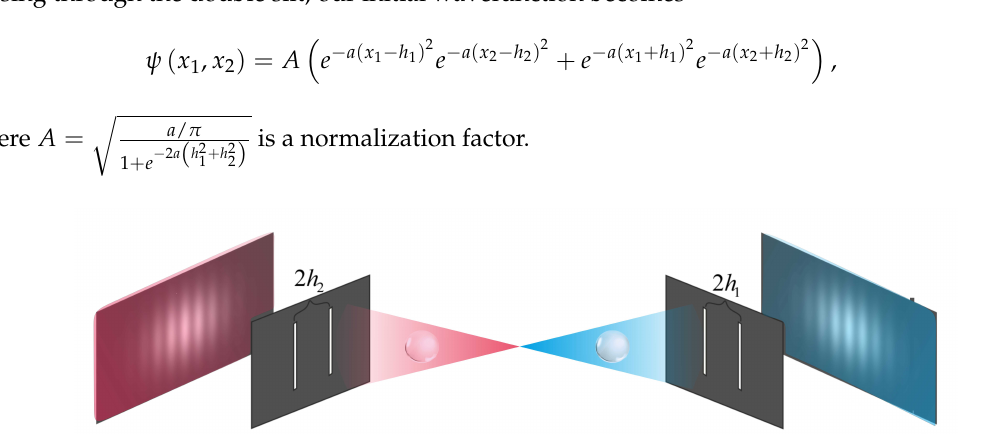
Figure 1. The proposed “double-double slit” setup: each particle of an entangled two-mode Gaussian state ψ θ ( x 1 , x 2 ) (5) is sent through a double slit with a screen behind it. The amount of quantum entanglement between the two particles is controlled by a parameter θ ∈ repeated many times with the same initial state, and the positions where the particles hit the screen are registered to infer the one-particle and two-particle probability distributions. Generally, the distance between each pair of slits may vary. The plotted probability distributions on the screens are for θ = π